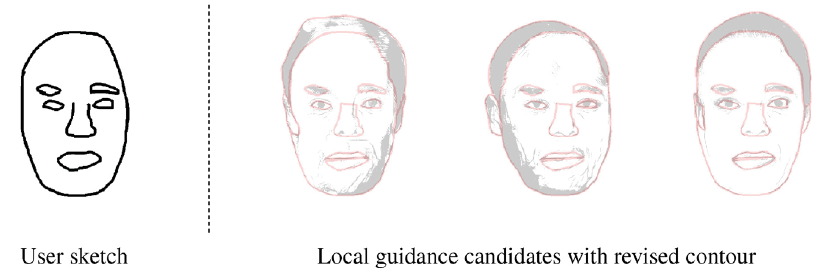
Fig. 11 Multiple reference candidates (right) generated from the user sketch (left) for local drawing guidance.